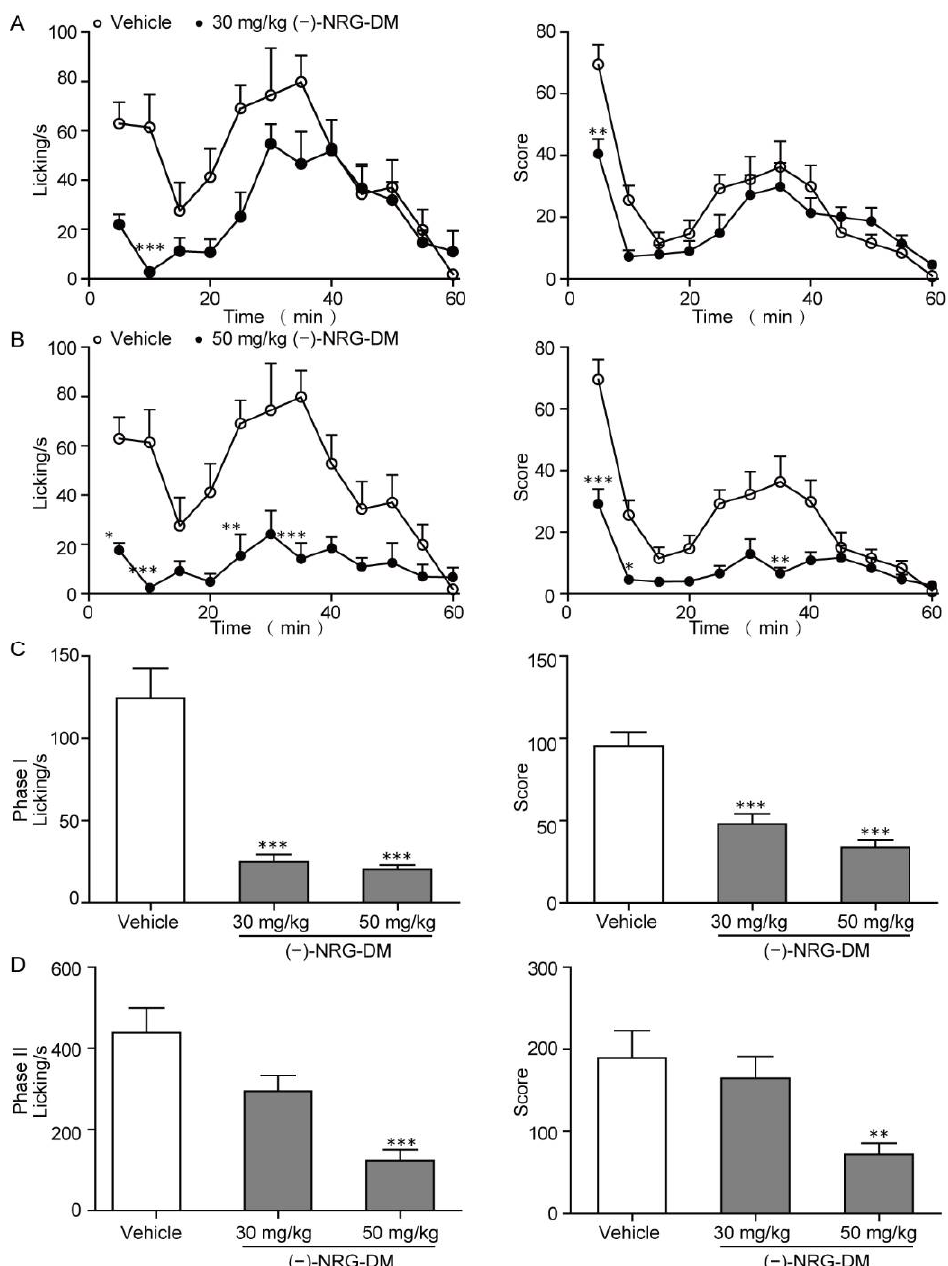
Figure 2. Analgesic effects of ( − )-NRG-DM in the formalin-induced mouse inflammatory pain model. ( A ) 30 mg/kg compound ( − )-NRG-DM attenuated the biphasic pain responses, including both licking time (left) and score (right) throughout the 60 min trial. ( B ) 50 mg/kg ( − )-NRG-DM attenuated the biphasic pain responses, including both licking time (left) and score (right) throughout the 60 min trial. Bar graph showing the effects of vehicle (white), 30 mg/kg and 50 mg/kg compound ( − )-NRG-DM (grey) on the pain behaviors during phase I ( C ) and phase II ( D ) in the formalin-induced mouse inflammatory pain model. In all groups, n = 10 animals. Statistical significance: * p ≤ 0.05, ** p ≤ 0.01, *** p ≤ 0.001.